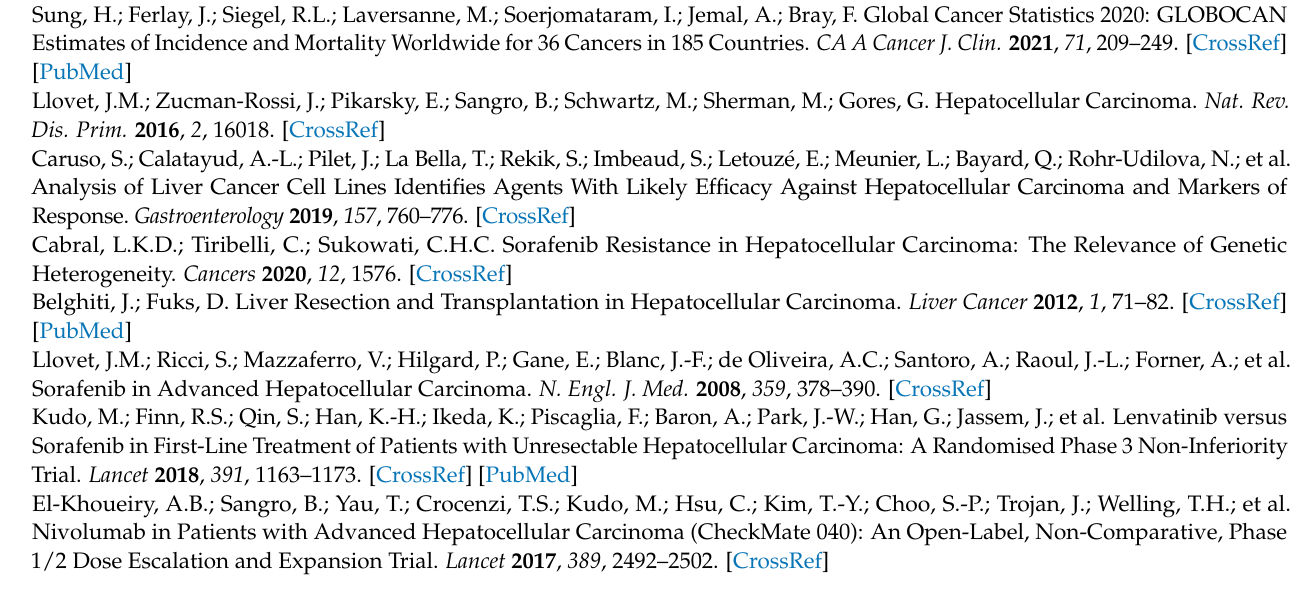
(PPI) analysis of the different HCC subtypes and groups from published datasets. Figure S2. Mean mRNA expression data from at least three independent replicates showing the dysregulation of proto- oncogene upon treatment from the cell lines investigated (including result of statistical analysis). Figure S3. The relevance of FGR in clinical samples of LIHC (gene expression distribution (normal vs LIHC) and overall survival data from GEPIA web